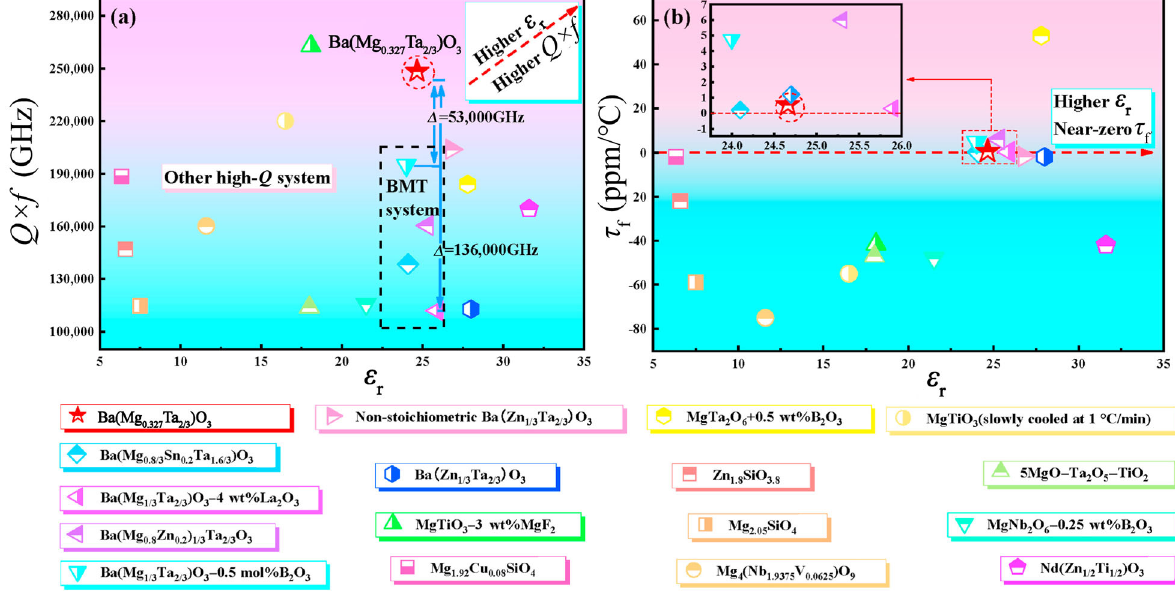
Fig. 25 Correlation between microwave dielectric properties of high- Q ( Q × f ≥ 100,000GHz) MWDCs: (a) Q × f versus ε r ; (b) τ f versus ε r . Reproduced with permission from Ref. [534], © Elsevier Ltd and Techna Group S.r.l.